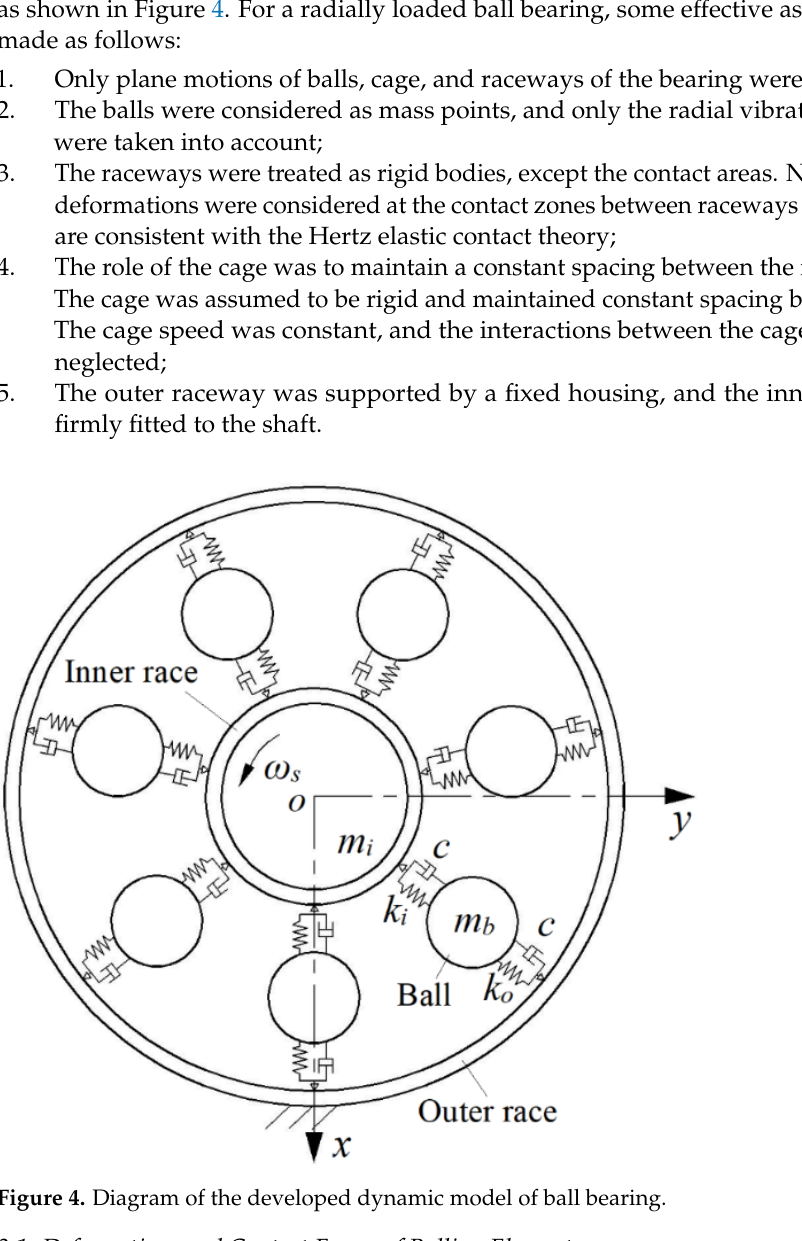
6 of 16 Figure 3. Relation between the friction coefficient and the sliding velocity.